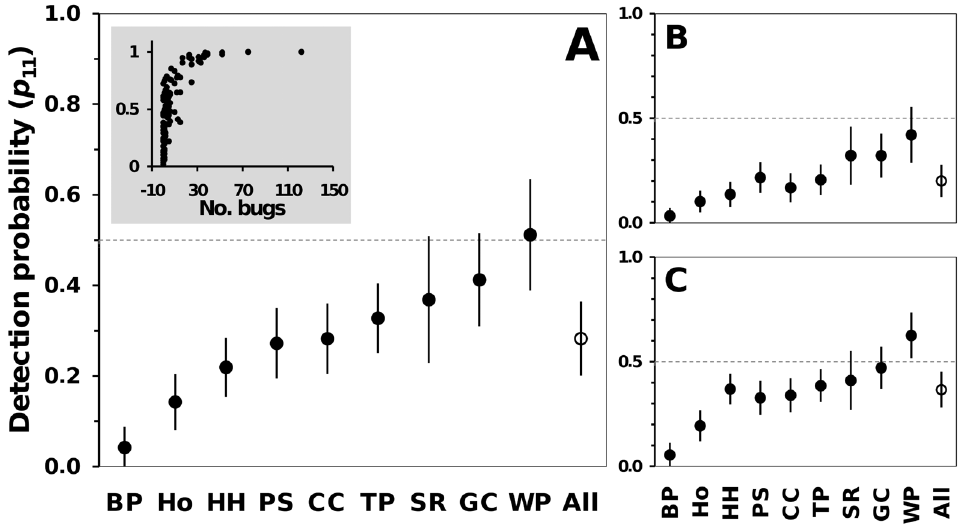
Figure 2. Model-weighted average estimates of Chagas disease vector-search sensitivity ( p 11 ) for different ecotope types. The means of model-averaged ecotope- and vector-search round-specific values are shown, with approximate 85% confidence intervals; in each panel, the mean vector-search sensitivity over all ecotope types (labeled ‘‘All’’) is represented by an empty circle, and 50% sensitivity is highlighted by dashed lines. A , estimates from the complete dataset, with ecotopes ranked by mean vector-search sensitivity; the inset shows the relationship between model- predicted sensitivity and observed vector density; B , estimates for the lightly-infested locality of Russas; C , estimates for the heavily-infested locality of Jaguaruana. Ecotopes: BP, brick pile; Ho, house; HH, henhouse; PS, pigsty; SR, storeroom; GC, goat/sheep corral; CC, cattle corral; TP, tile pile; WP, woodpile. See Table S2 for further details.